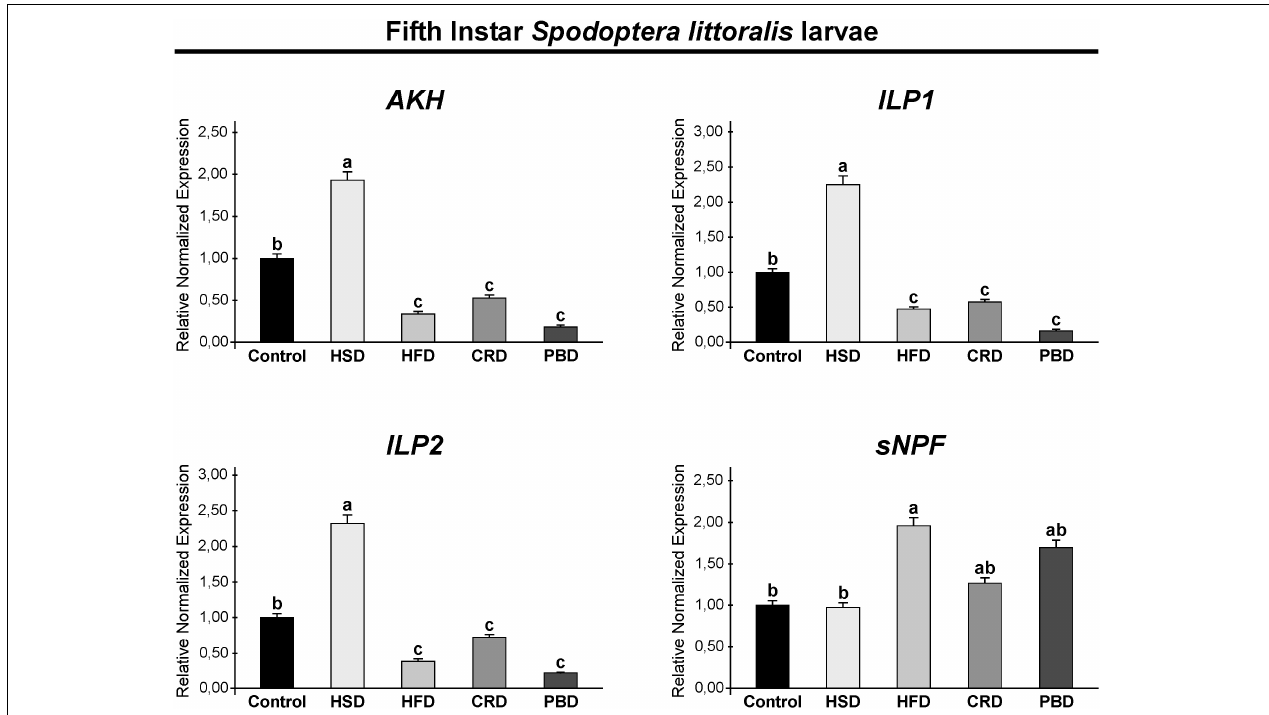
FIGURE 6 | Effects of different diet treatments on the expression of Spodoptera littoralis adipokinetic hormone ( SpoliAKH ), insulin-like peptide 1 ( SpoliILP1 ), insulin-like peptide 2 ( SpoliILP2 ), and short neuropeptide F ( SpolisNPF ) at fifth instar larvae by Real-time PCR. Spodoptera littoralis actin gene was used as the internal reference. The statistical significance of transcript abundance differences among groups was determined through ANOVA, followed by the Tukey HSD test (groups associated with different letters are significantly different from each other, p < 0.05). Values are expressed as means ± standard error. Control, Regular artificial bean diet; HSD, High sugar diet; HFD, High fat diet; CRD, Calcium-rich diet; PBD, Plant-based